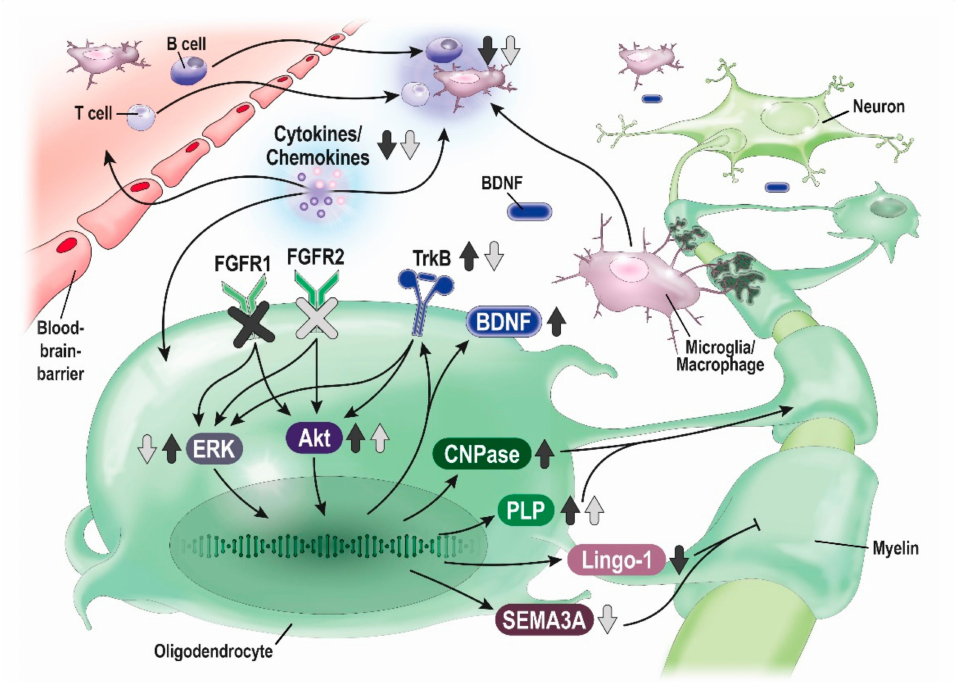
Figure 2. Effects of oligodendrocyte-specific deletion of FGFR1 and FGFR2 in EAE. Proposed neuroprotective and anti-inflammatory mechanisms of oligodendrocyte-specific deletion of FGFR1 (dark grey arrows) and FGFR2 (bright grey arrows) in MOG 35-55 -induced EAE (according to [108] and